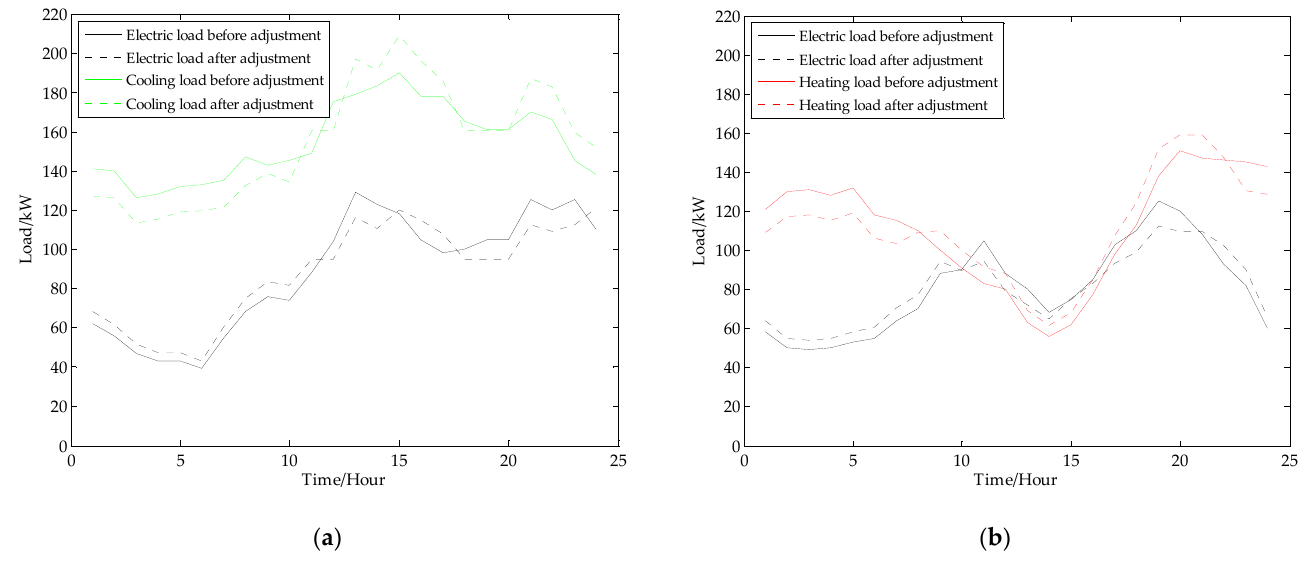
Figure 4. Optimization results in case 4: ( a ) summer and ( b ) winter. Table 5. Cost comparison of case 3 and case 4 in summer.